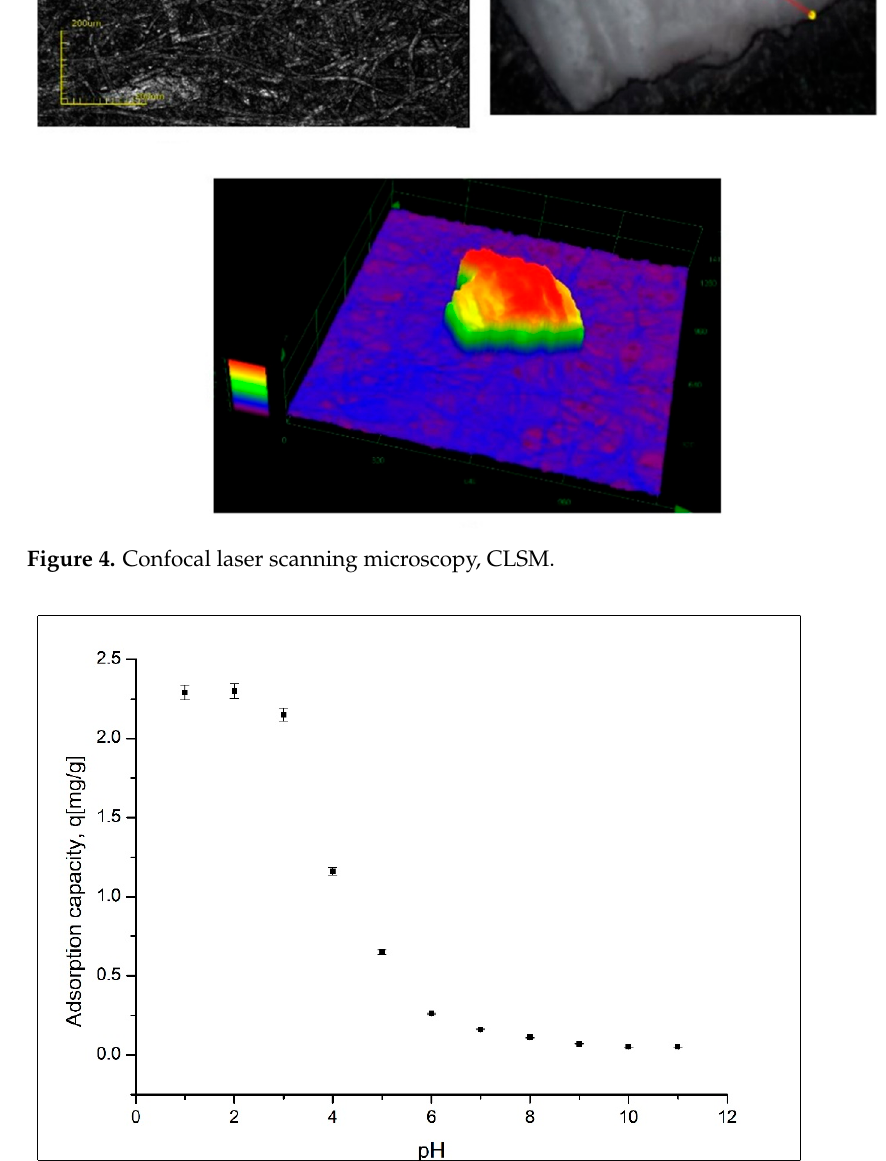
Figure 5. pH effect.